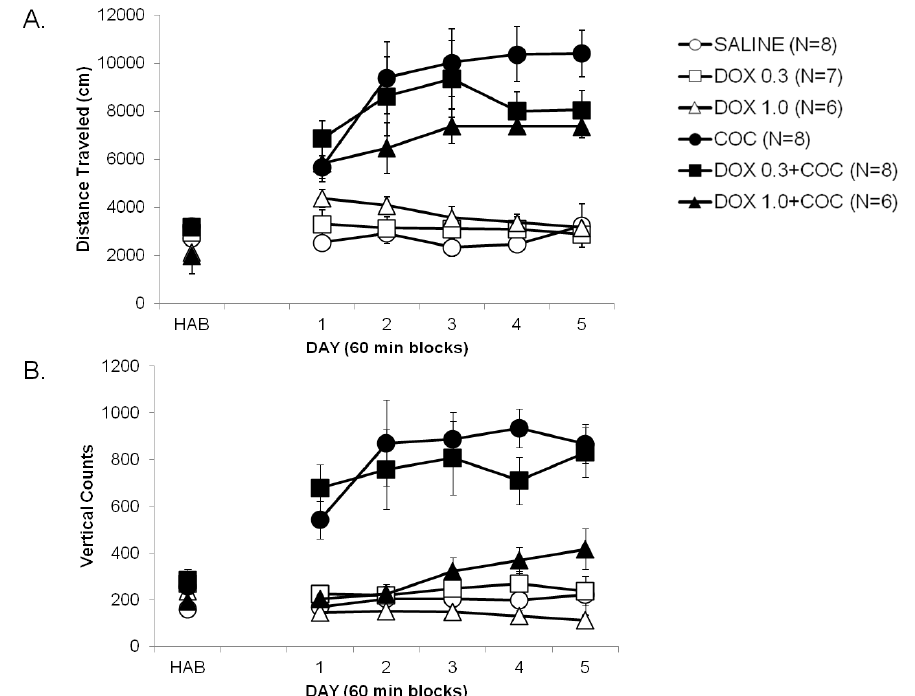
Figure 1. The development of cocaine locomotor sensitization is presented as mean ± standard error of mean (SEM) locomotor activity assessed as ( A ) distance traveled (cm) and ( B ) vertical counts over 5 consecutive days of drug treatments. Groups of rats ( N ) were administered vehicle ( ○ ), cocaine ( ● , COC; 10 mg/kg; intraperitoneally, IP), doxazosin ( □ , DOX; 0.3 or Δ , 1.0 mg/kg, IP), or the combination of DOX 0.3 ( ■ ) and 1.0 ( ▲ ) plus COC. DOX alone did not affect gross locomotor activity compared to saline. DOX (1.0 mg/kg) significantly blocked the development of COC-induced increases in vertical counts ( B ) across